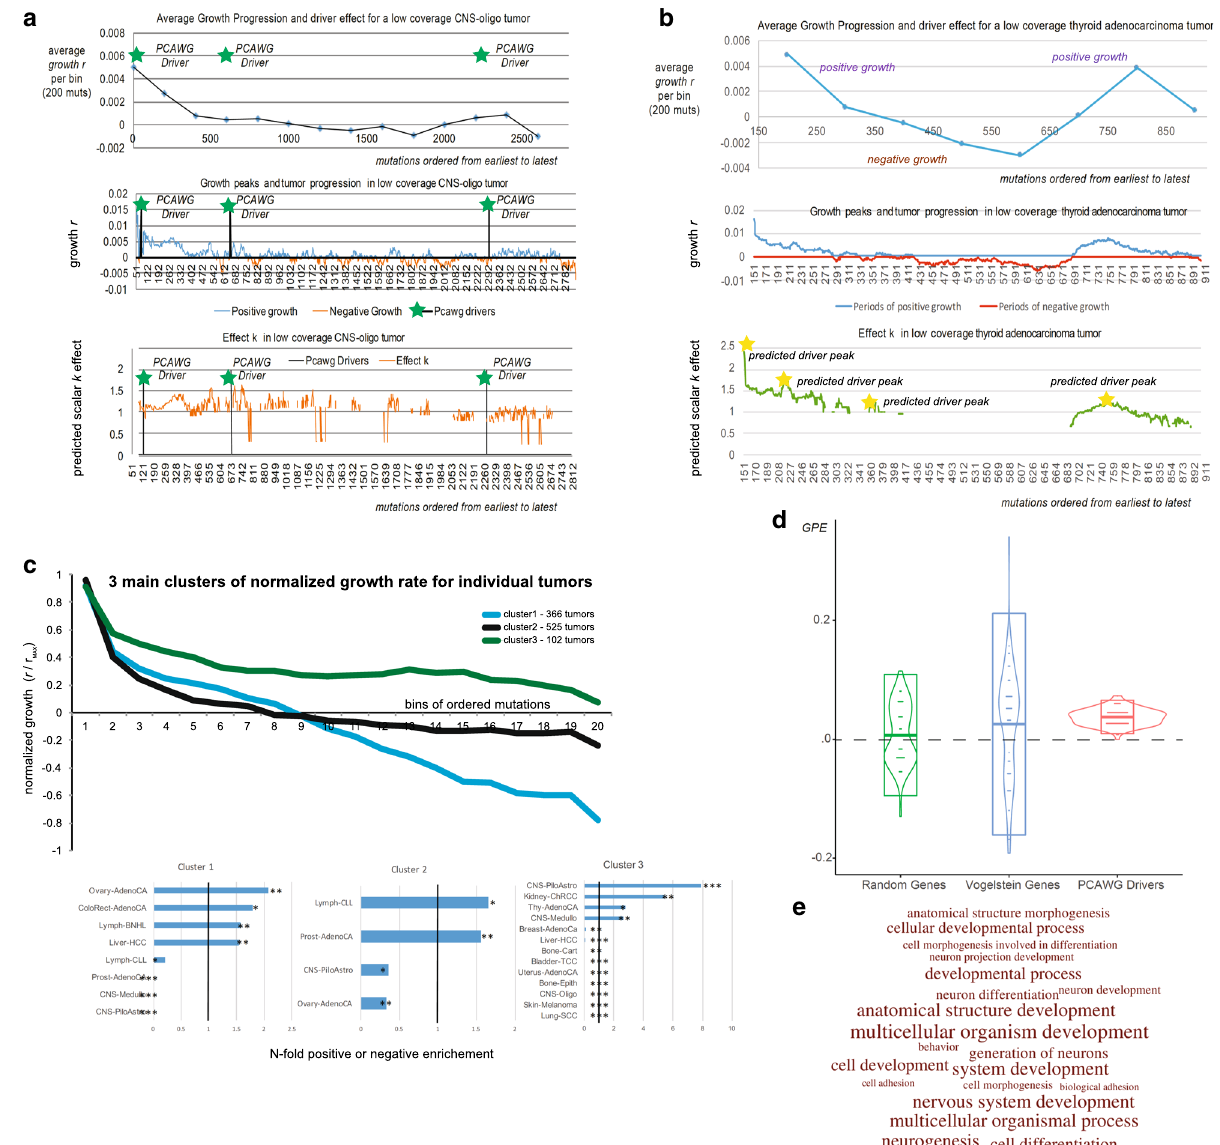
Fig. 3 Growth patterns and growth associations using 993 linear tumors. Across 993 linear tumors from PCAWG consortium we expect an under- selection mutation to be associated with periods of positive growth. We compared several mutation types (driver mutation, mutation within geneX, within GO categoryX), to a random distribution from their respective sample for association with positive growth. a , b The averaged growth progression, mutational growth, and mutational effect, for a single low-coverage CNS-oligo tumor and a single low-coverage thyroid adenocarcinoma tumor without any PCAWG-identi fi ed drivers. Green asterisks denote the ordered position of a PCAWG-predicted driver within the sample. Yellow asterisks denote a growth peak and putative driver presence. In c , we derived three main growth patterns (steady growth, sigmoid growth, and stagnation/shrinkage) for 993 linear tumors, as they were grouped using a k -means clustering algorithm. Various cancer types showed speci fi c enrichment or depletion for the three clusters (levels of signi fi cance for Fisher ’ s tests for enrichment noted as *, **, and *** for p < 0.05, 0.01, and 0.001). In d , PCAWG drivers and Vogelstein genes show signi fi cant positive growth enrichment compared to a list of random highly mutated genes. Boxplots represent 2 × σ deviation, lines represent the mean, while violin plots are trimmed to data range. e We show the GO enrichment for the 20 most affected biological processes, when we use 293 genes, signi fi cantly associated with periods of positive